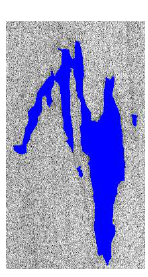
Figure7: Ground truth data imposed on the power image of VV